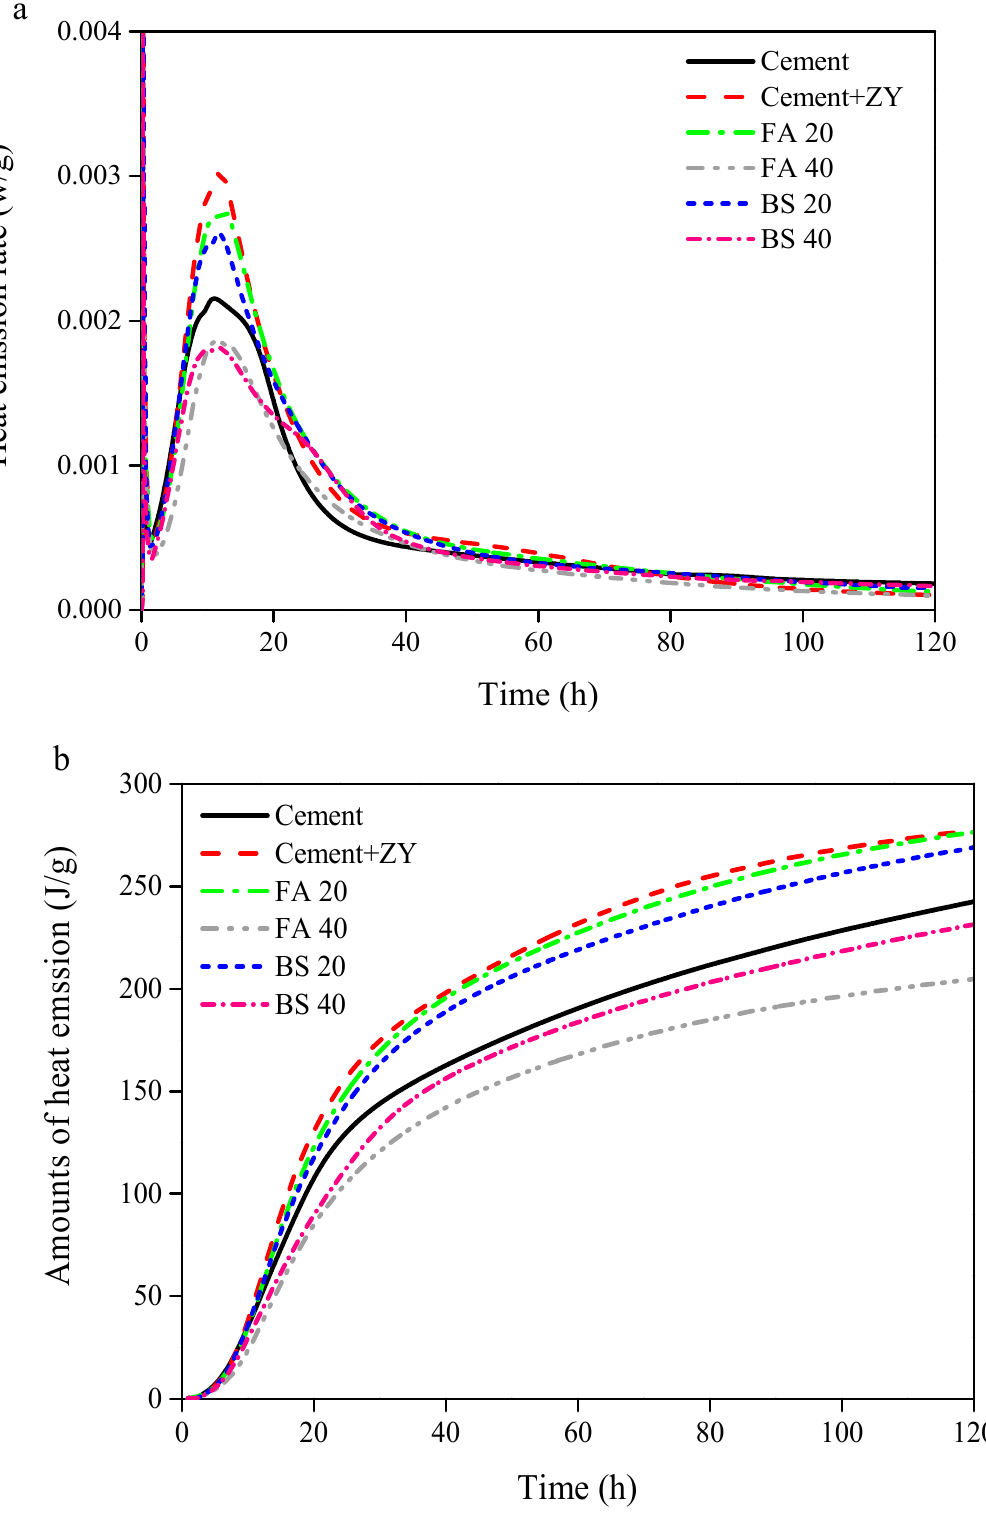
Figure 2. ( a ) Early hydration heat emission rate of cement pastes at 293 K and ( b ) early hydration heat of cement pastes at 293 K. The detailed compositions of the six cement pastes are shown in Table 2. As seen in Figure 2b, the early hydration of cement paste with ZY-type ™ expansive agent released much higher heat than that of cement, proving additions of ZY-type ™ expansive agent would improve the cement reaction [23]. Because the fly ash or slag could weaken the hydration-